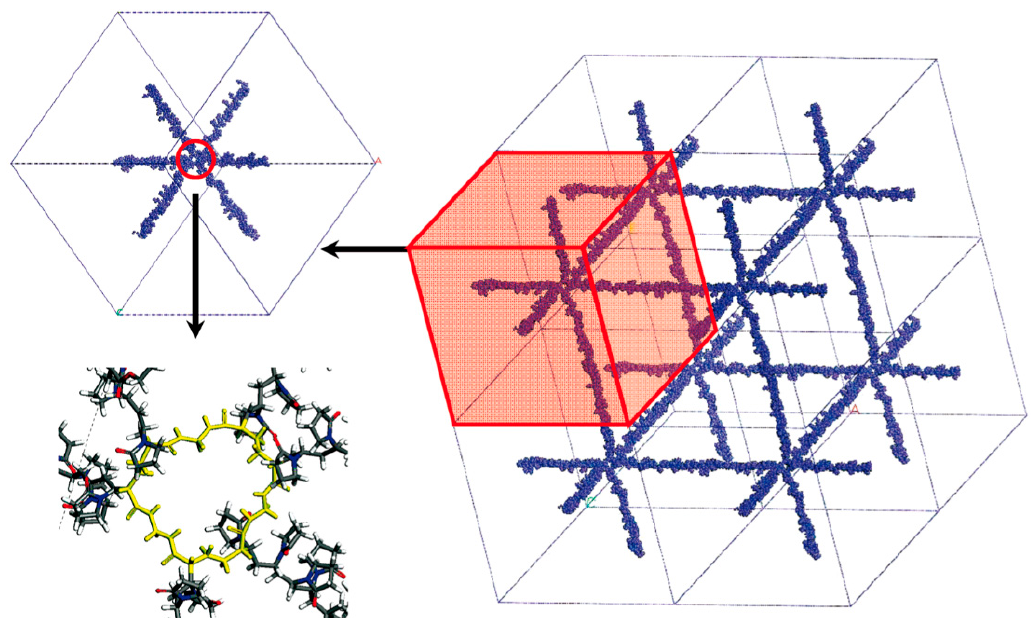
Figure 2. Schematization of the modeling approach adopted by Lee and coworkers. A building block that contains some cross-linked chains is repeated in space by means of periodic boundary conditions, obtaining a regular network. Adapted with permission from Lee et al. [33], Copyright 2009 American Chemical Society.